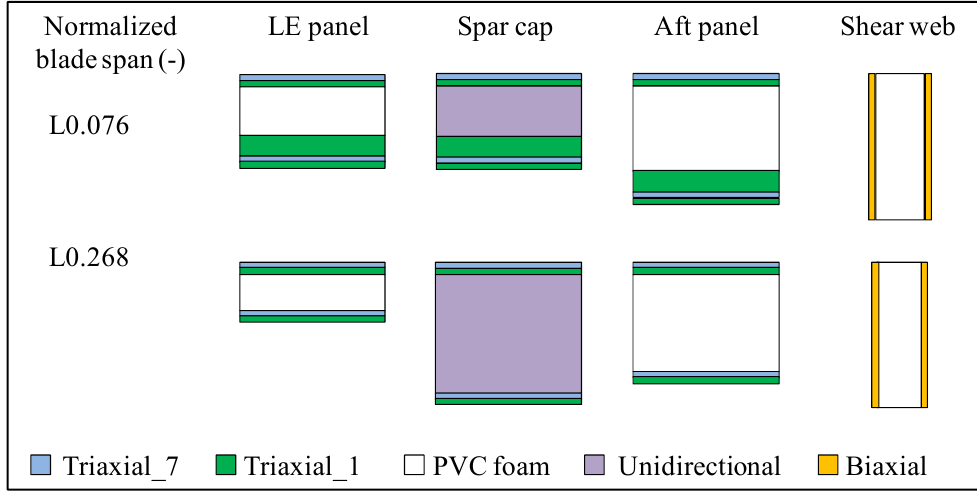
Figure 2. Representative composite layups of the blade.